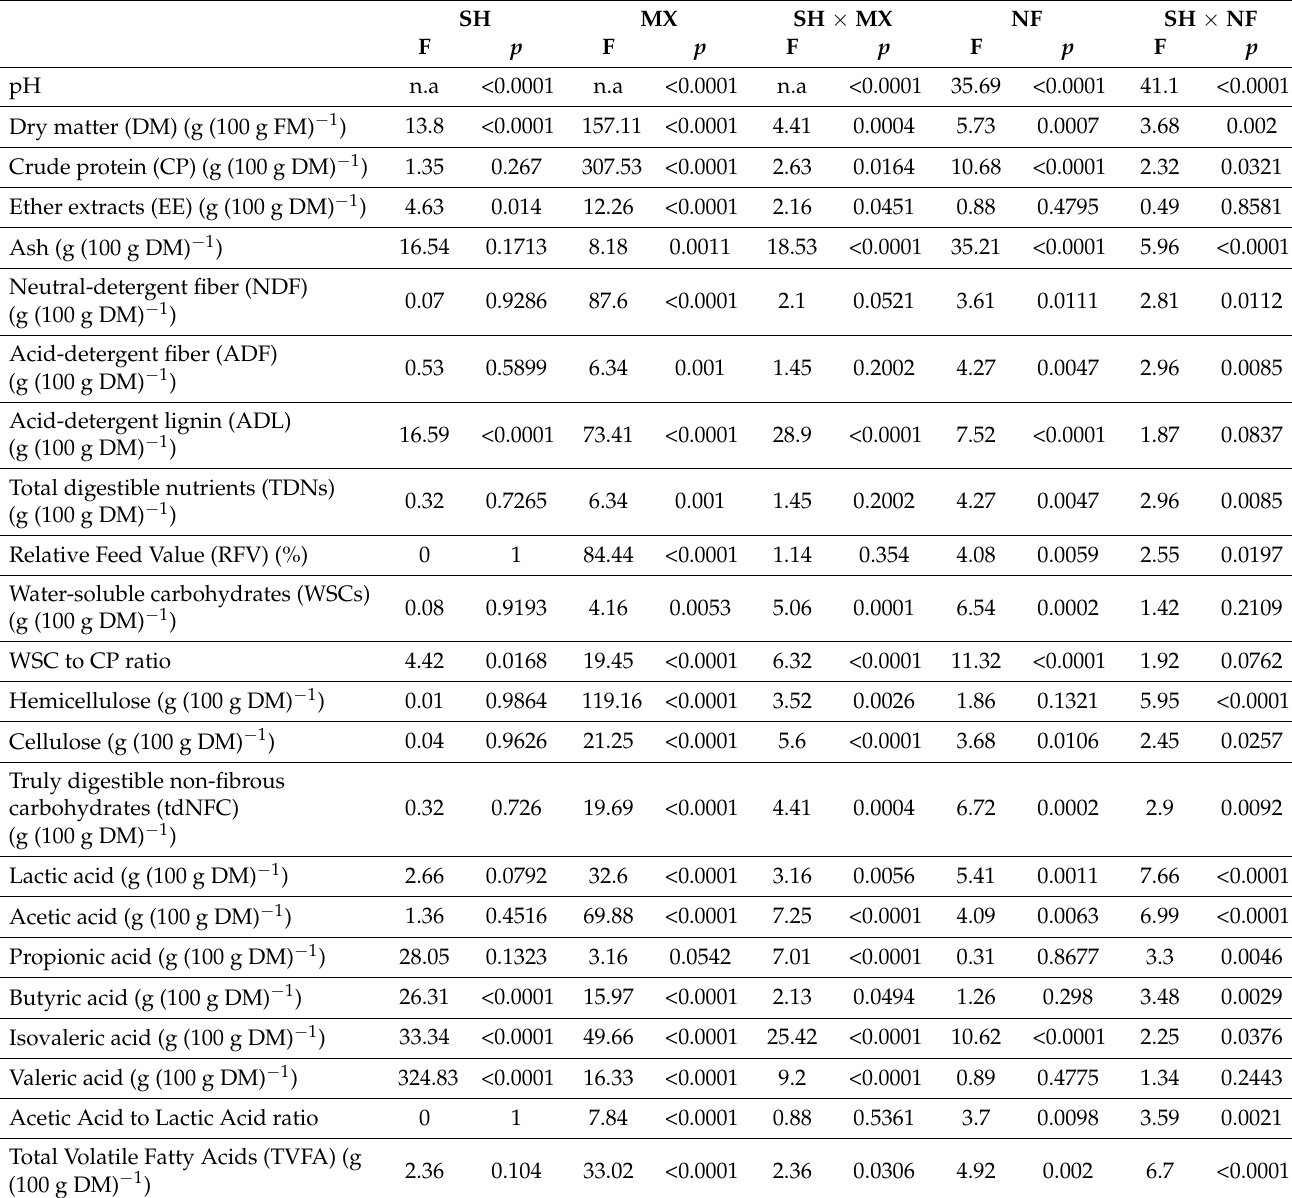
Table 2. F statistic and p -values of the general linear mixed model applied to the variables measured in the silage. Factors were the time of sampling (SH): early, mid and late; the mix (MX): pure fertilized or unfertilized barley and pure faba bean whole biomasses and their 75:25, 50:50, and 25:75 mixes (MX); and the barley fertilization (NF), either fertilized or not, nested into the mixture since the pure faba bean was not